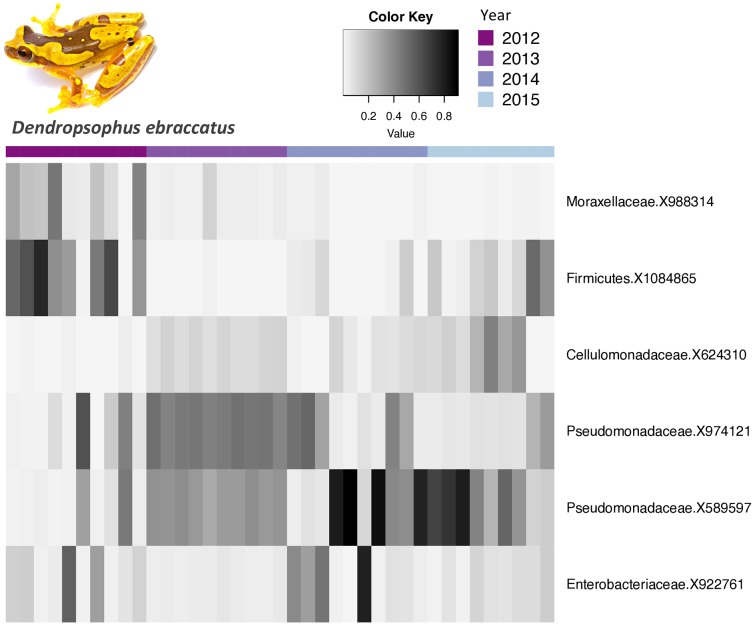
Relative abundance of core bacterial taxa on Dendropsophus ebraccatus across years.Relative abundance of Dendropsophus ebraccatus core bacterial taxa (OTUs found on 100% of the frogs) across years. Darker shades indicate higher relative abundances and lighter shades indicate lower relative abundances. Photo credit: Brian Gratwicke.